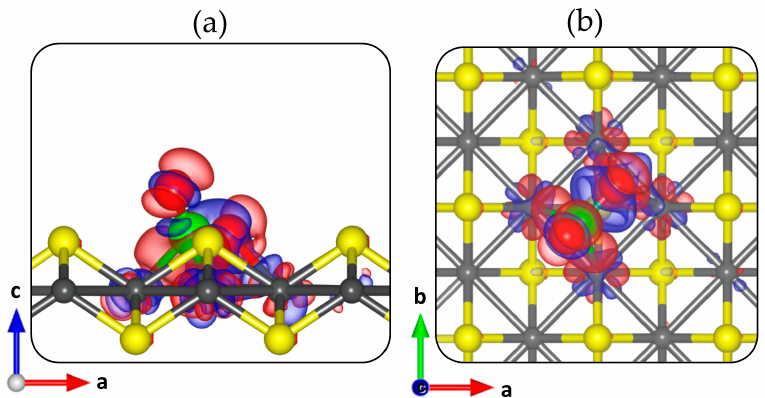
Figure 4. Side ( a ) and top ( b ) views of the differential charge density isosurface contours upon CO 2 adsorption on the defective V S1 FeS (001) surface. The red and blue regions denote electron density accumulation and depletion by 0.02 e/Å 3 , respectively.